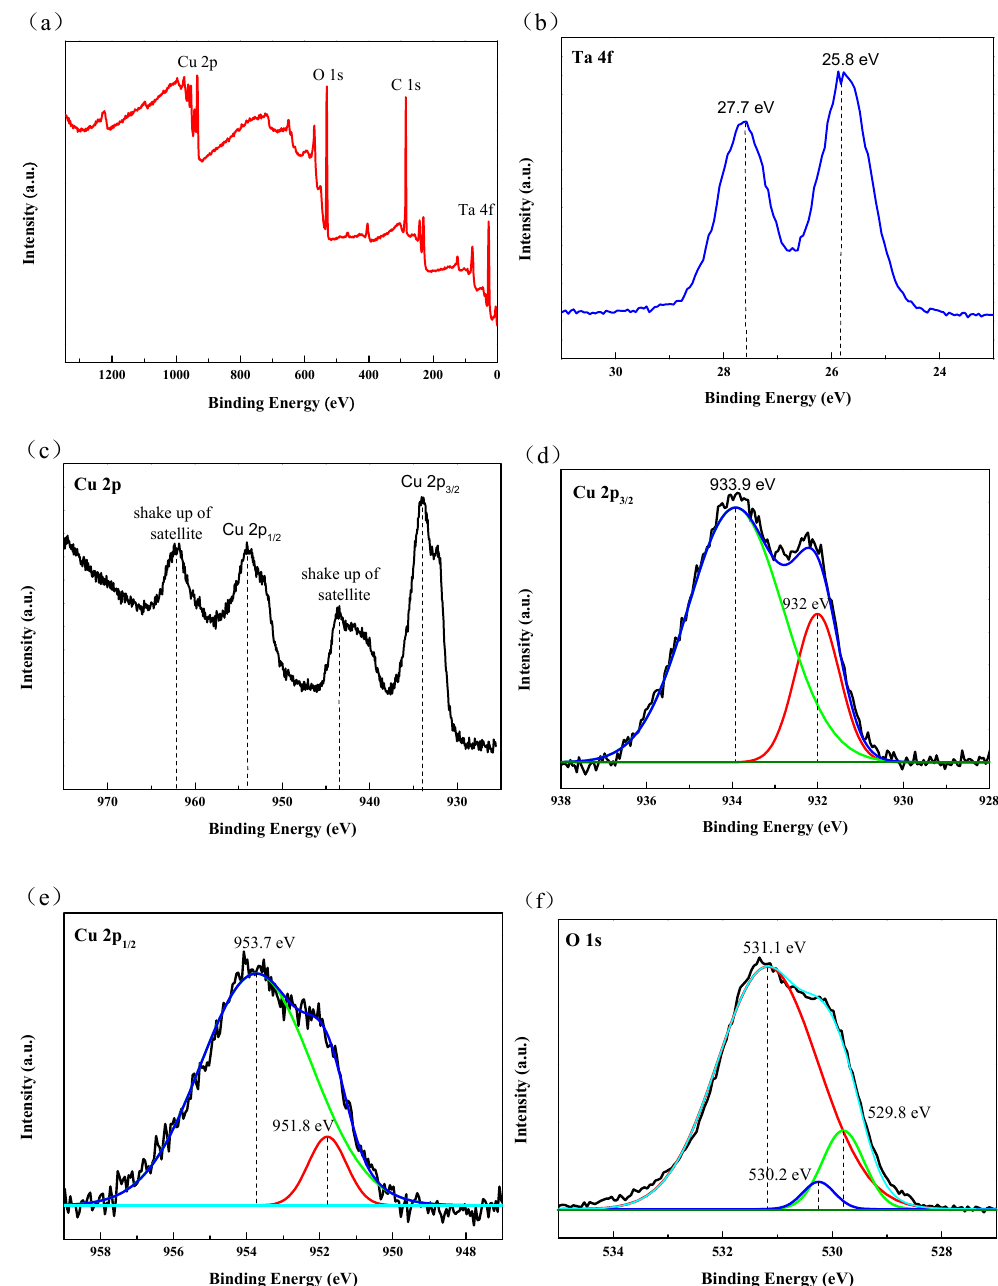
Figure 8. ( a ) XPS survey spectrum and ( b ) Ta 4f, ( c – e ) Cu 2p, ( f ) O 1s high-resolution spectra of the C3 coating sample.